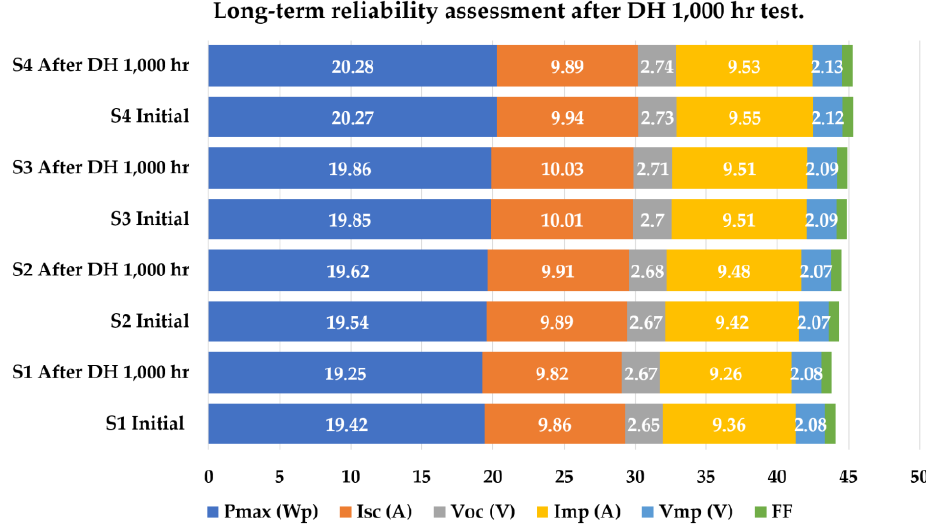
Figure 9. Comparison chart of estimated values and experimental values of samples S1 – S4.